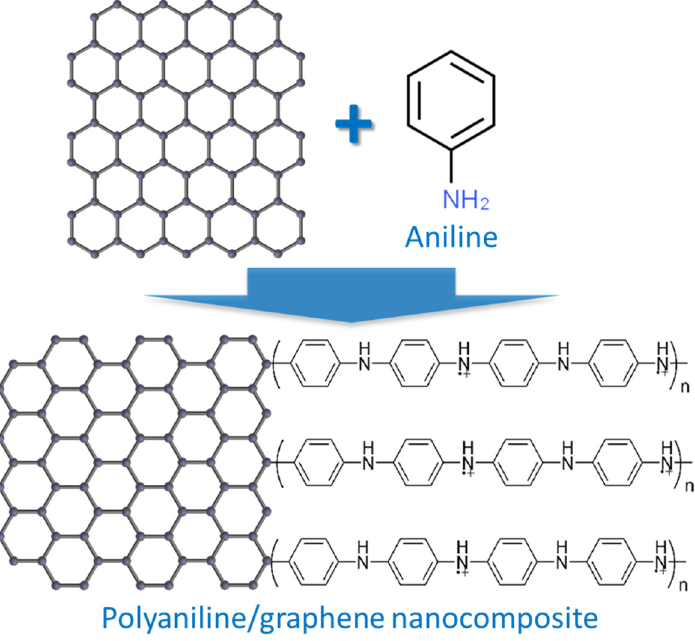
Figure 5. Formation of polyaniline/graphene nanocomposite.